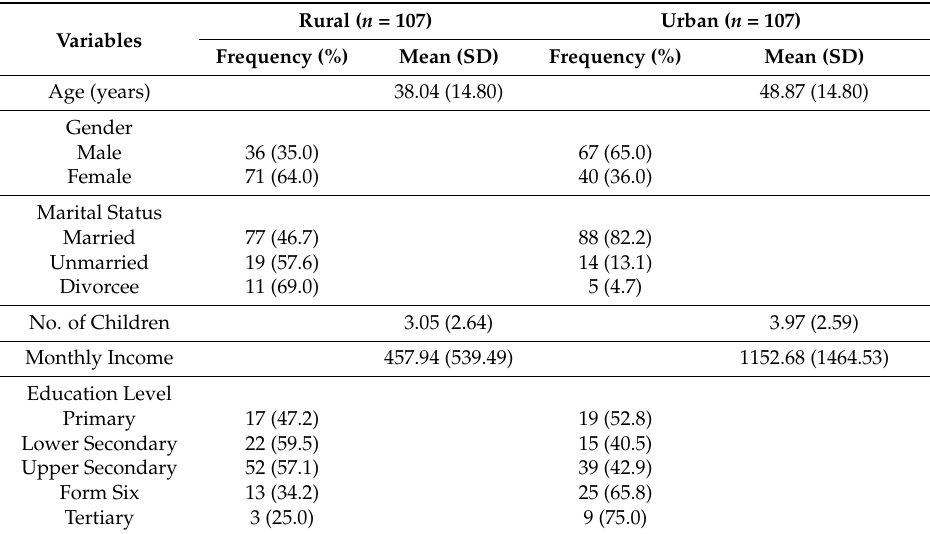
Table 1. Sociodemographic characteristics of the respondents ( N =